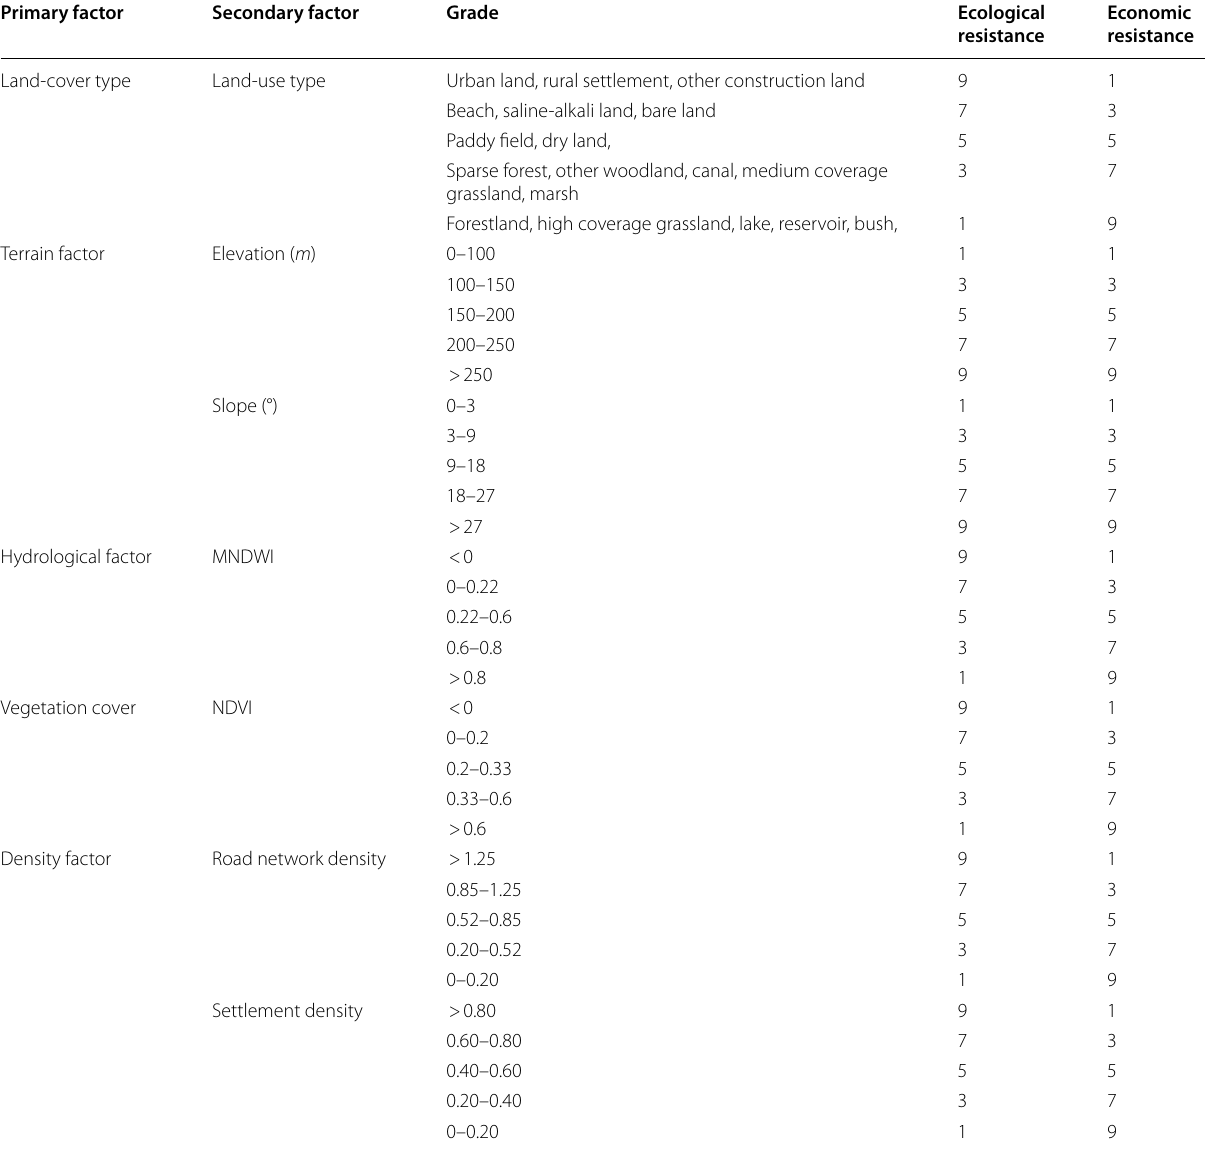
MNDWI modified normalized difference water index, NDVI normalized difference vegetation